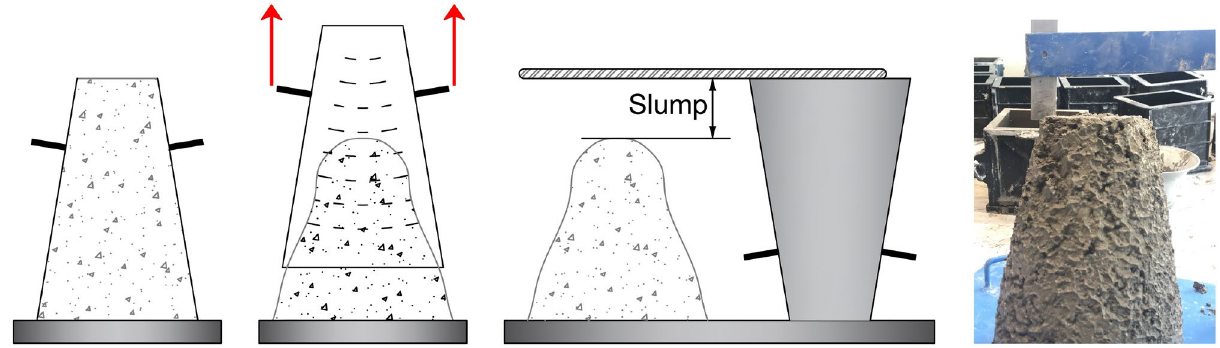
Figure 4. Schematic of slump testing of the concrete